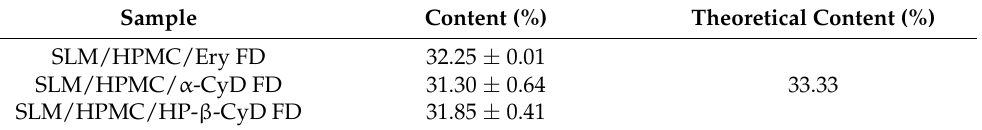
Table 5. Silymarin (SLM) contents in silymarin/hypromellose nanoparticles (SLM/HPMC NPs) in the presence of erythritol (Ery), α -cyclodextrins ( α -CyD), and hydroxypropyl (HP)- β